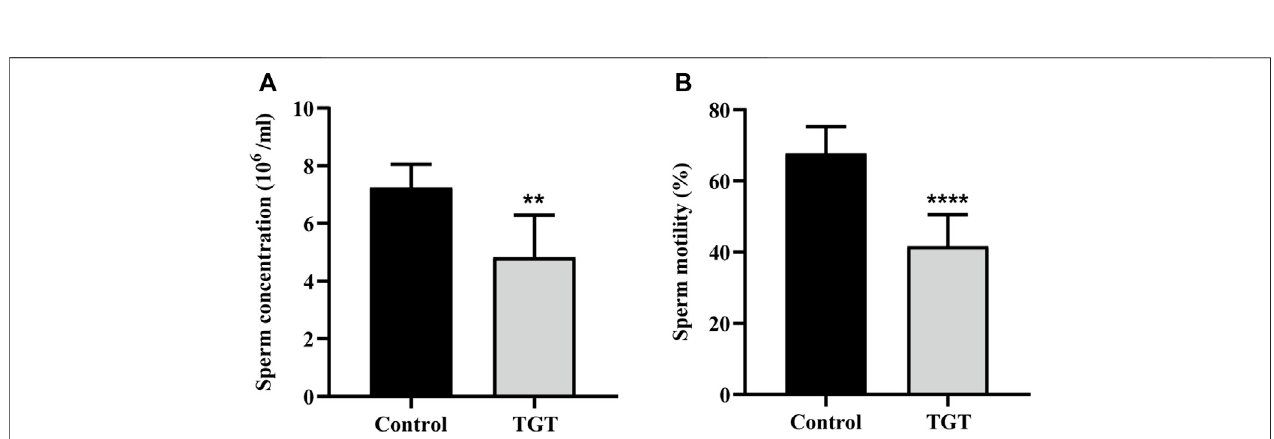
FIGURE 3 | (A) The sperm concentration of the rats on week 12. (B) The sperm motility of the rats on week 12. All values represent the means ± SD ( n = 7, compared with the control group: pp p < 0.01 pppp p < 0.0001).